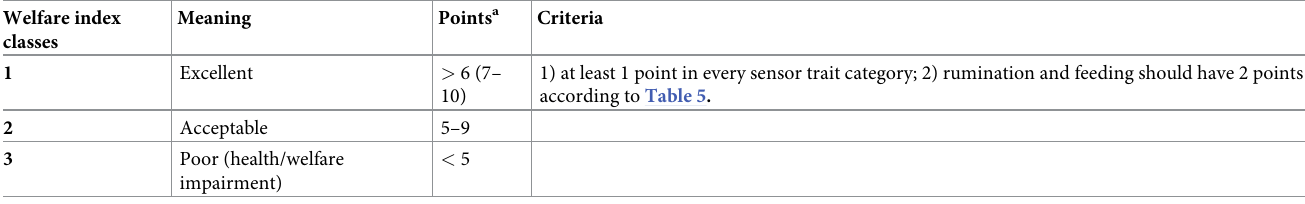
Table 6. Composed welfare index classes based on the welfare quality assessment protocol 1 [76].